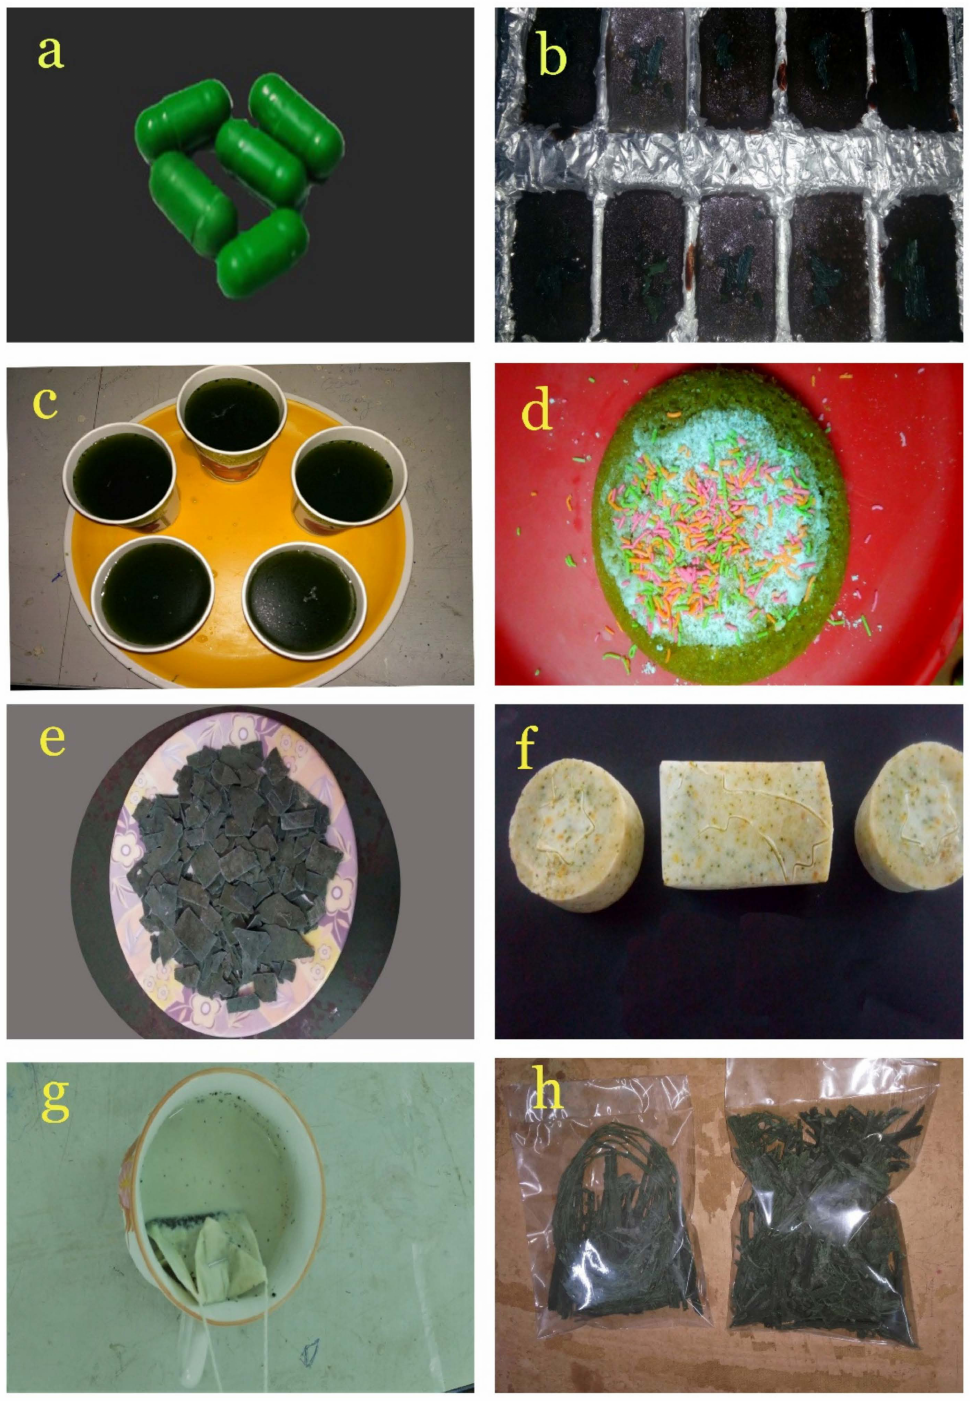
Figure 10. Value-added products from Spirulina sp. ( a ) Spirulina Capsule, ( b ) Spirulina Choco- late, ( c ) Spirulina Juice, ( d ) Spirulina Cake, ( e ) Spirulina Pasta, ( f ) Spirulina Soap, ( g ) Spirulina Tea, ( h ) Spirulina